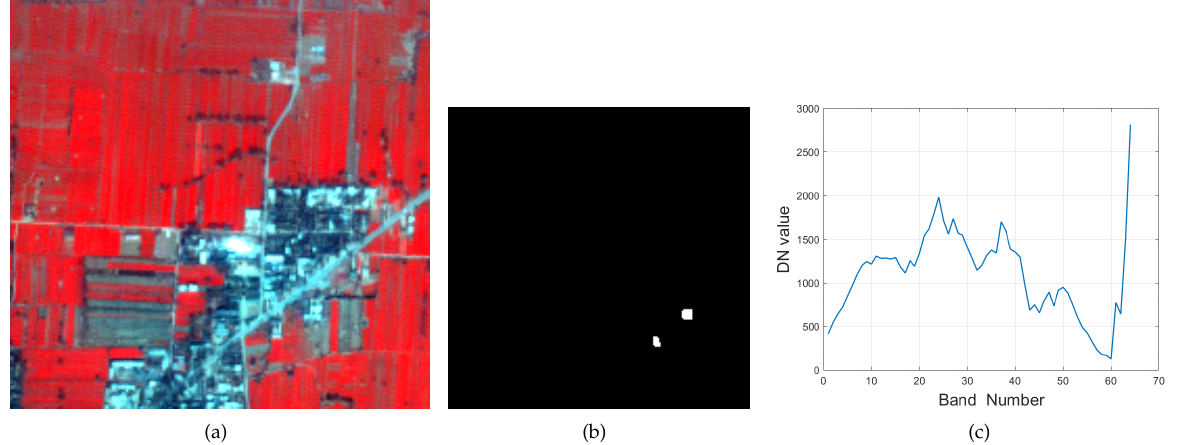
Figure 2. The false color image ( a ) (R:750.6 nm, G:559.6 nm, B: 510.1 nm) and the groundtruth image ( b ) for the Xi’an data with 64 bands. ( c ) The selected spectrum of the target of interest.